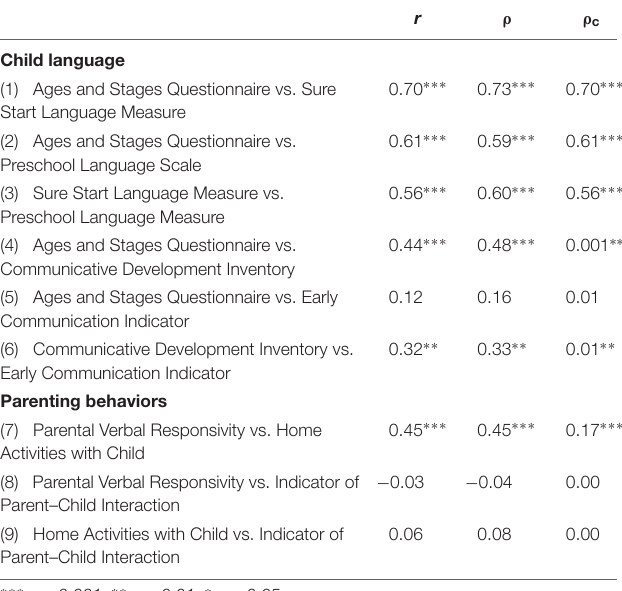
TABLE 4 | Pearson’s ( r ), Spearman’s Rank ( ρ ) and Lin’s Concordance ( ρ c ) correlation coefficients for each of the nine